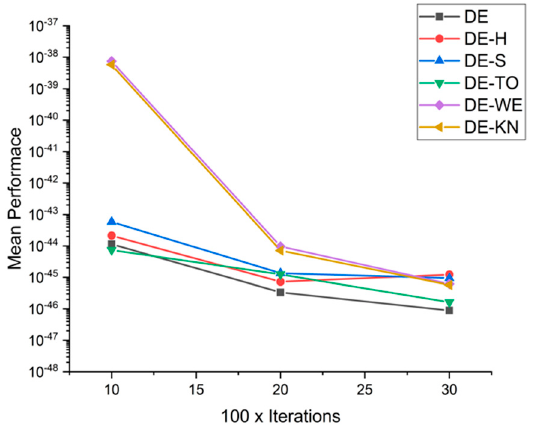
Figure 23. Convergence curve on fn1.